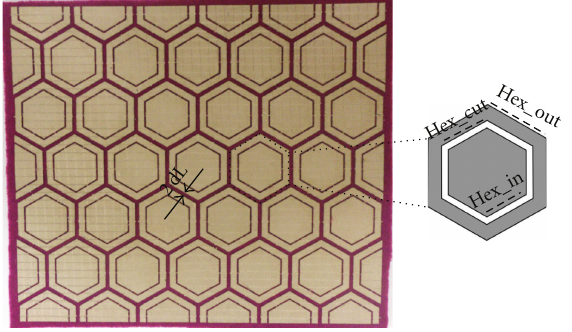
Figure 12: Dual-band textile hexagonal AMC-manufactured pro- totype: top view and unit-cell detail.